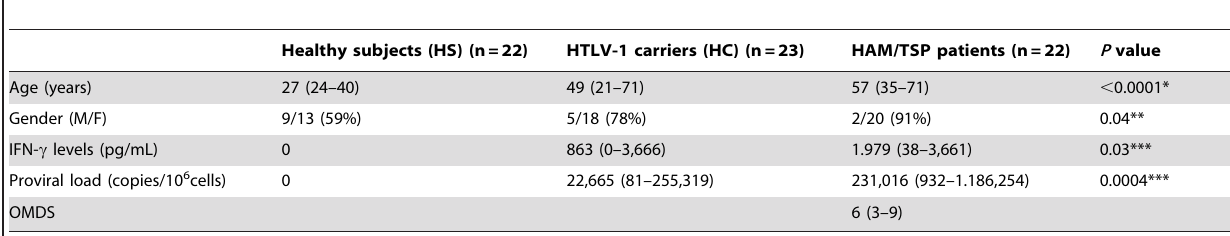
Table 1. Demographic characteristics, IFN- c production by PBMCs, proviral load and OMDS from HTLV-1 carriers and HAM/TSP patients.